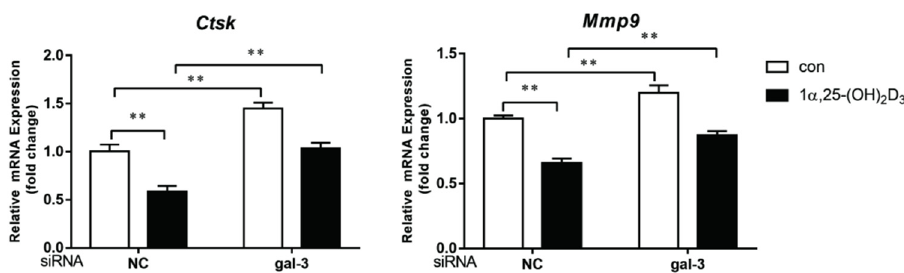
Figure 8. Gal-3 knockdown attenuated the inhibitory effect of 1 α ,25-(OH) 2 D 3 on OC-related gene expression. Histograms show relative expression levels of genes. Data are shown as means ± SD. n = 3, ** p < 0.01.